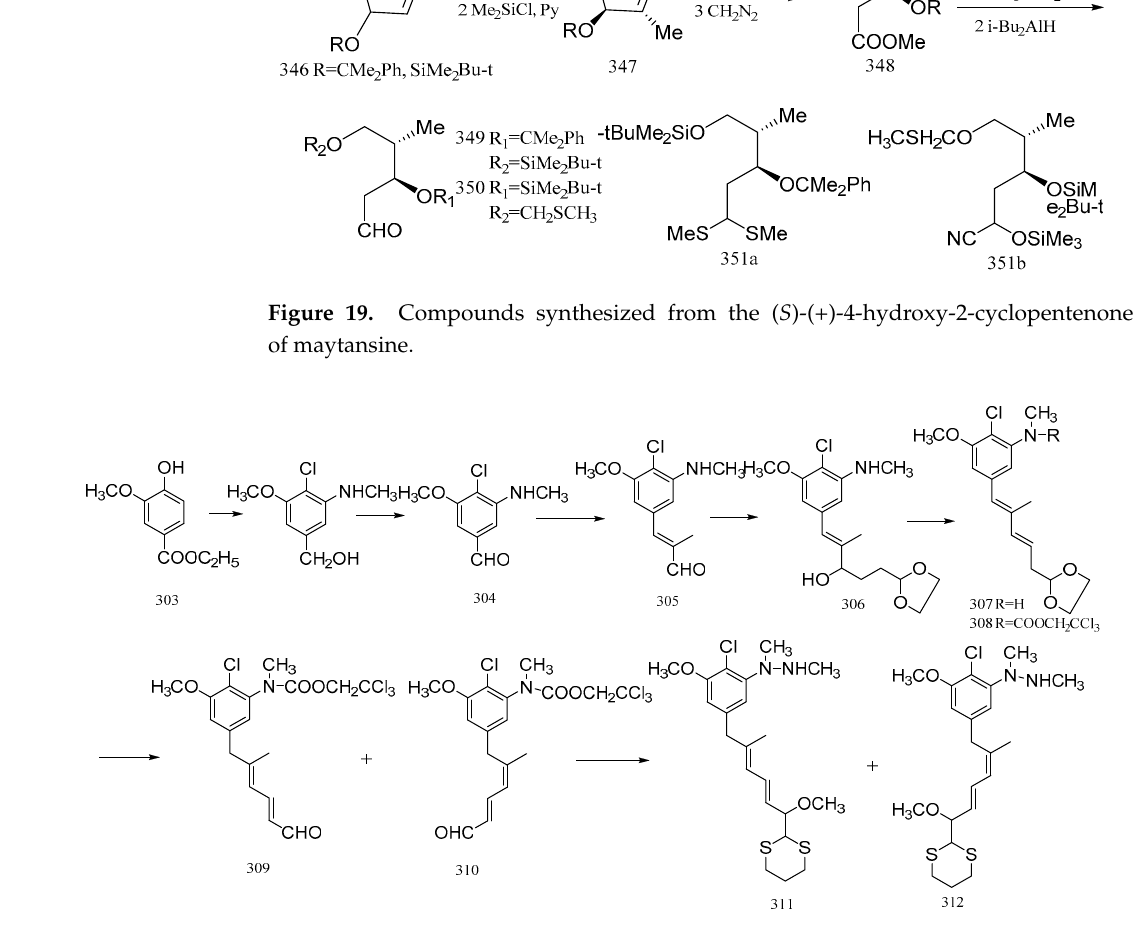
Figure 20. Synthesis of the substituted aromatic portion and the C9 to C15 moiety of maytansine.